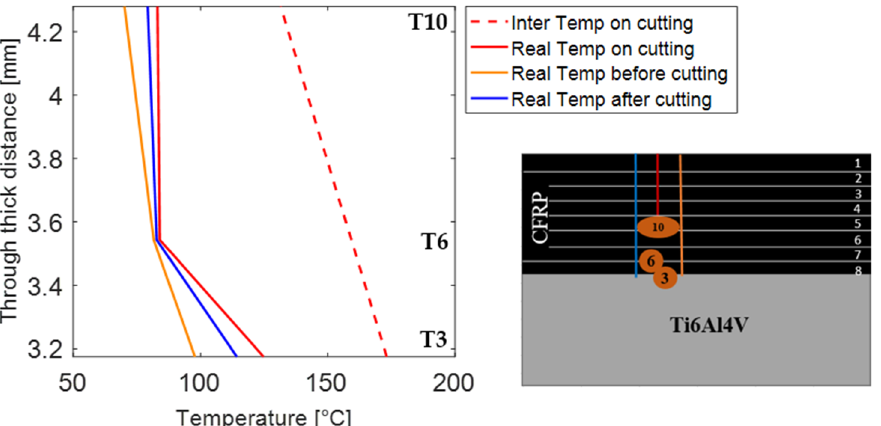
Figure 14. The temperature along the stack depth for thermocouples 3-6-10 within the [0]8/Ti6Al4V stack using tool3 and cutting conditions of v of 175m/min, ft of 0.05 mm/tooth, and ae of 1mm.